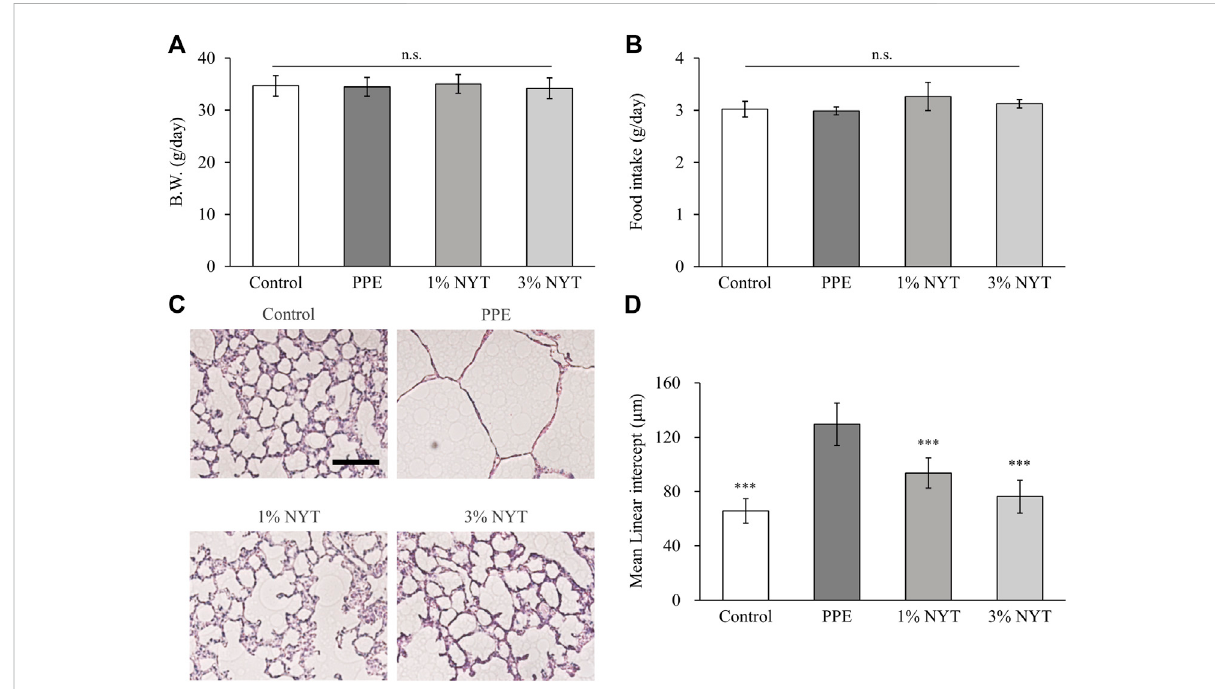
FIGURE 2 Effect of ninjin ’ yoeito (NYT) in lung tissue of PPE-induced COPD mice. (A) Average body weight and (B) food intake for NYT chow treatment term. (C) Lunghistopathological analysisbyhematoxylinandeosinstain.Scalebar=100 µm. (D) Meanlinearinterceptoflungparenchyma.(Control n = 10, PPE n = 11, 1% NYT n = 8, 3% NYT n = 7). Values are expressed as means ± S.D. ppp p < 0.001 vs. PPE group by Tukey test.